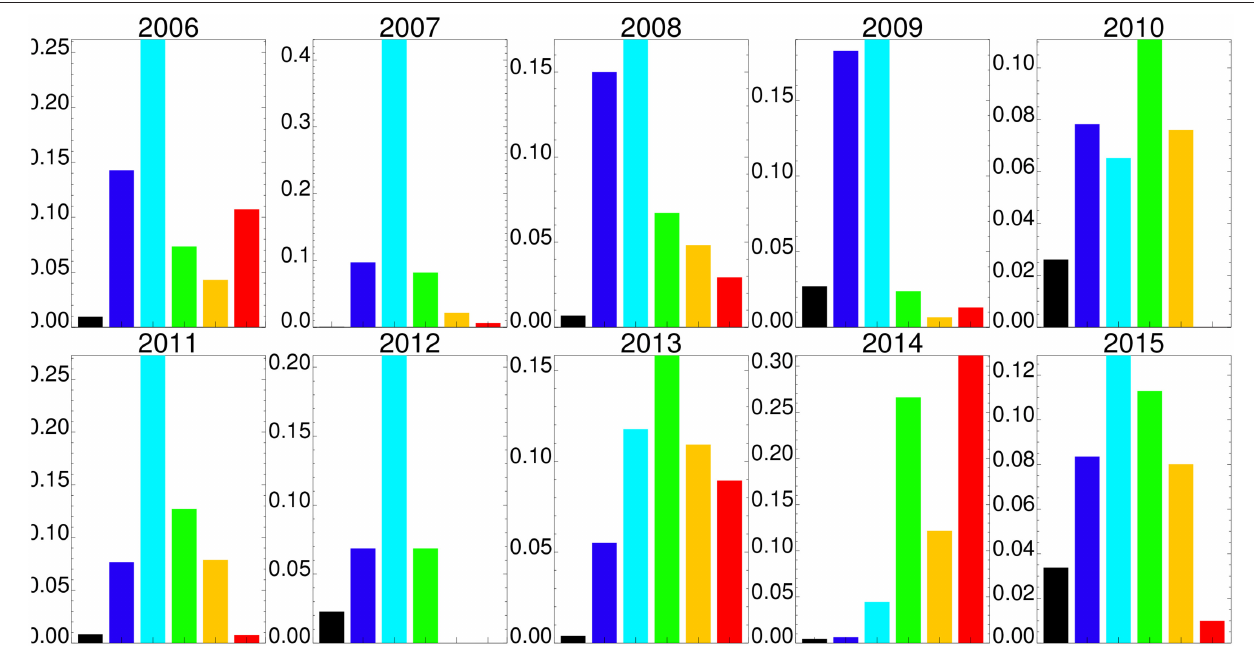
FIGURE 6 | Fraction of observation area with brash (black), cakes (floes < 20 m width, blue), small floes (20–100 m, light blue), medium floes (100–500 m, green), large floes (500–2,000 m, orange) and vast floes ( > 2,000m, red). Only shown for observations where floe size was recorded for all primary, secondary and tertiary ice types present if they were first year or